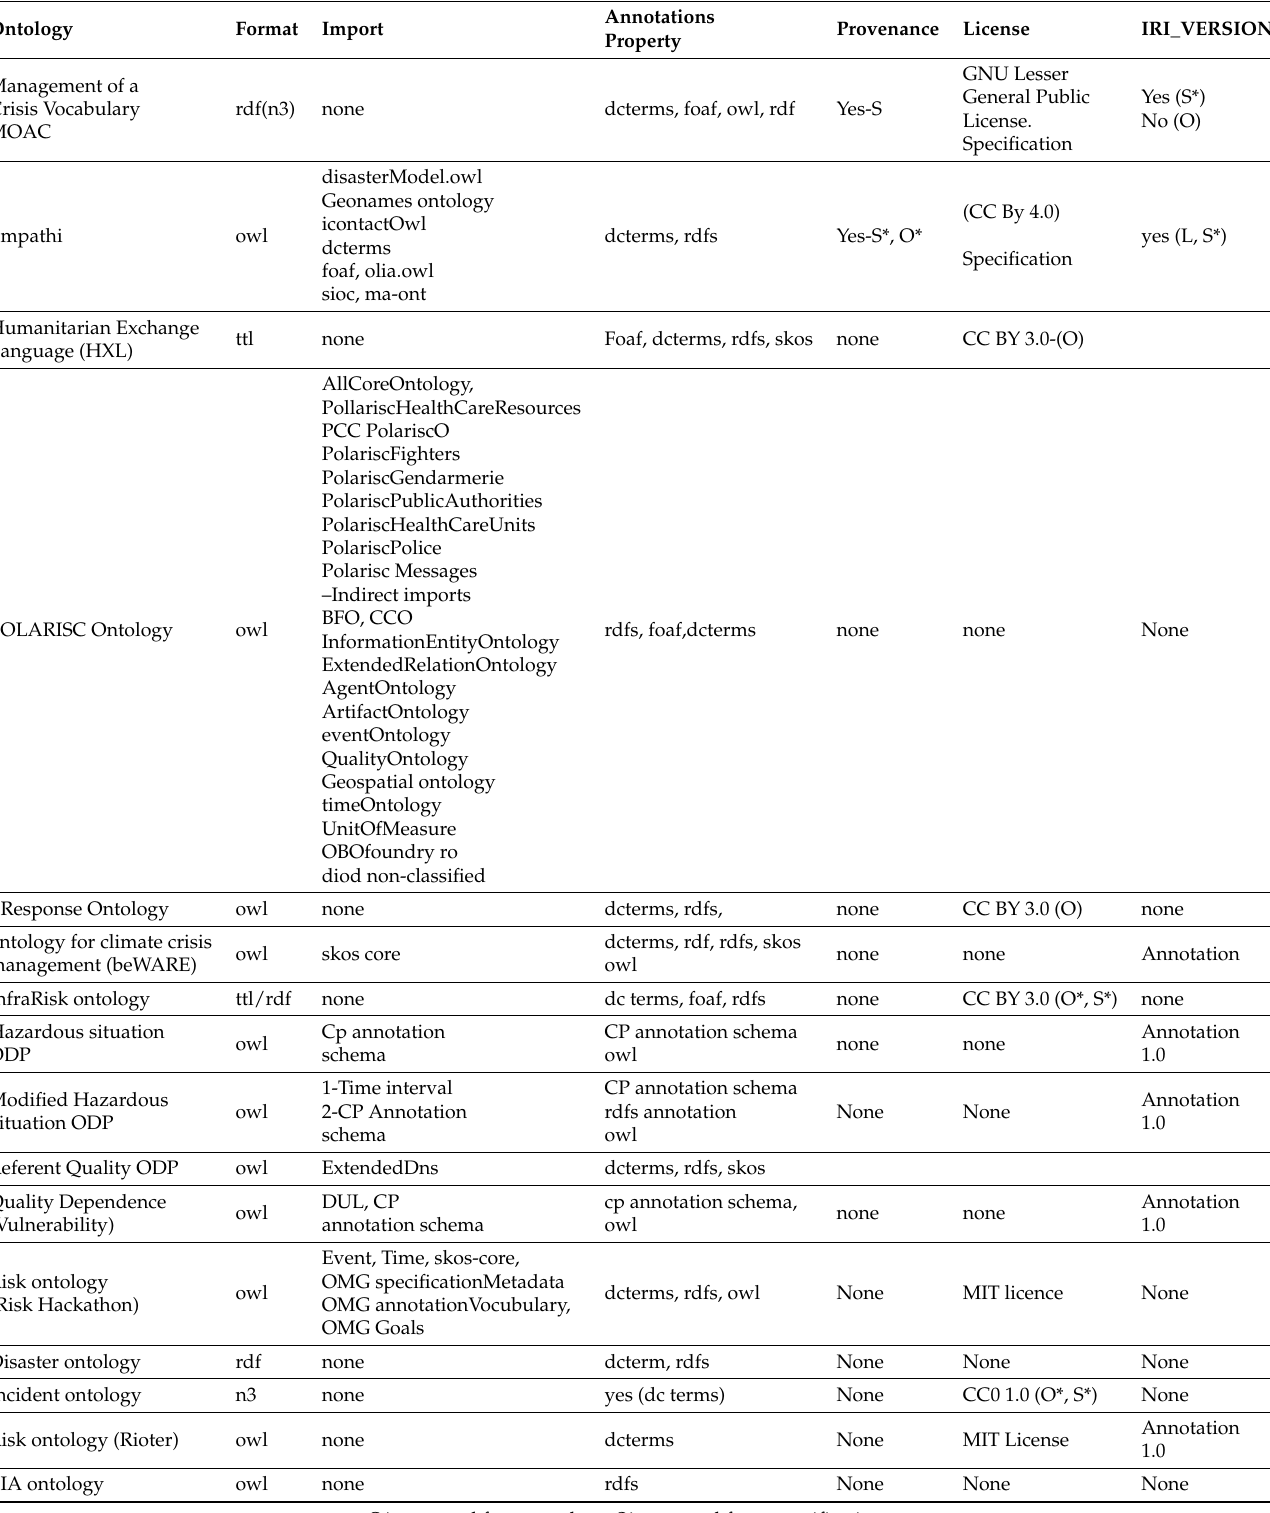
Table 9. Comparison of Resolvable Ontologies within the Disaster